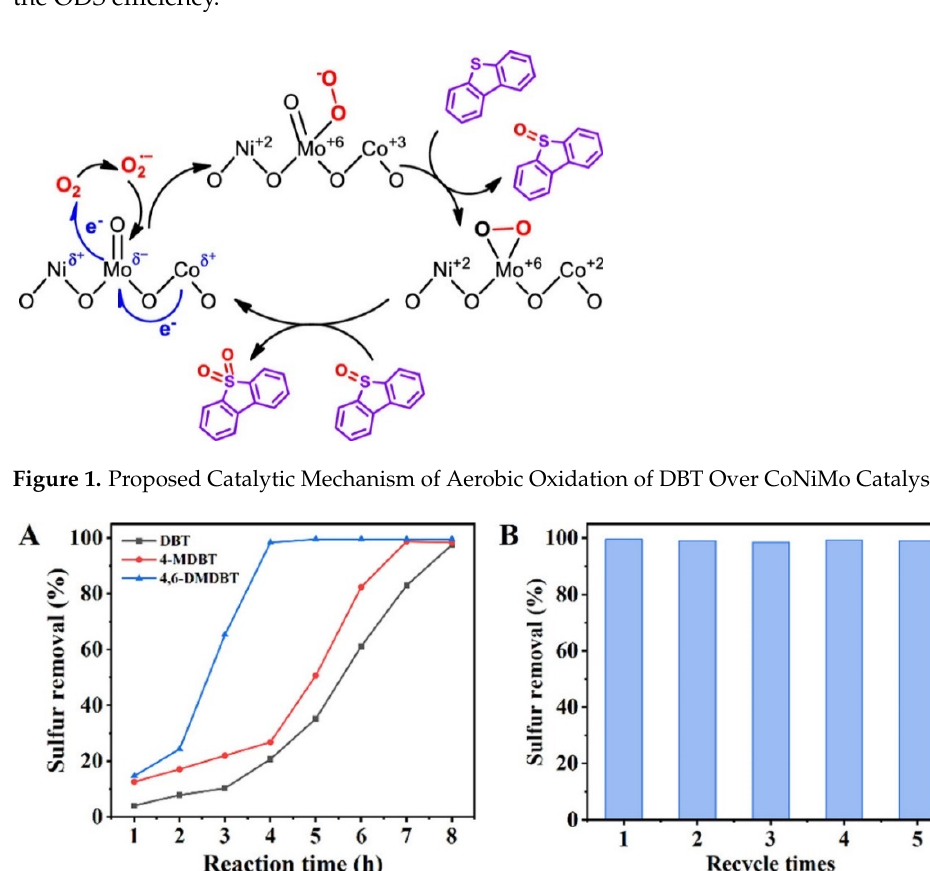
Figure 2. ( A ) Aerobic ODS tests on various sulfur compounds at 120 °C and ( B ) recycling performance of the 3DOM WOx-400 sample [68].